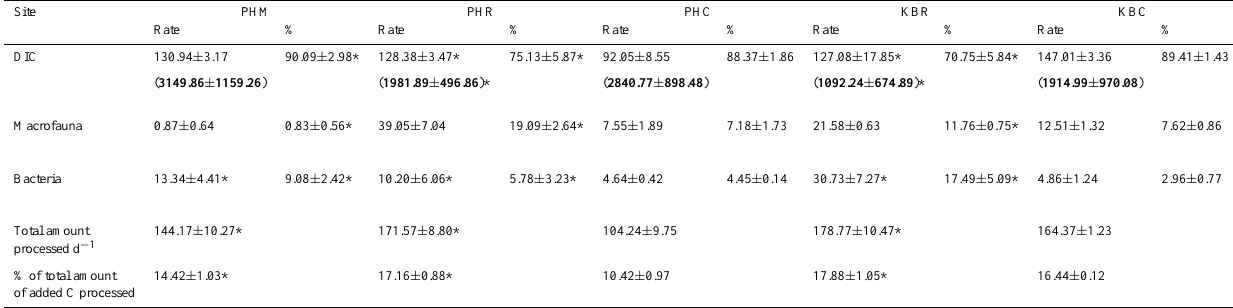
Table 3. Mean rate (mg g C − 1 m − 2 d − 1 ± 1SE, n = 3) and percentage ( ± 1SE, n = 3) of DIC production, faunal C-uptake and bacterial C-uptake from added algal-C in experiments from all 5 sites. Total amount of C processed d − 1 (mg g C − 1 m − 2 d − 1 ± 1SE, n = 3) and the percentage of total added C which was processed is also shown. Numbers in bold denote mean total daily DIC efflux normalized to algal-C (mg g C − 1 m − 2 d − 1 ± 1SE, n = 3) and were calculated using a molar mass weight for C of 12. Star ( ∗ ) denotes mean ± range of 2 samples when there was insufficient water or sediment sample for accurate DIC and PLFA measurements from a 3rd replicate chamber.